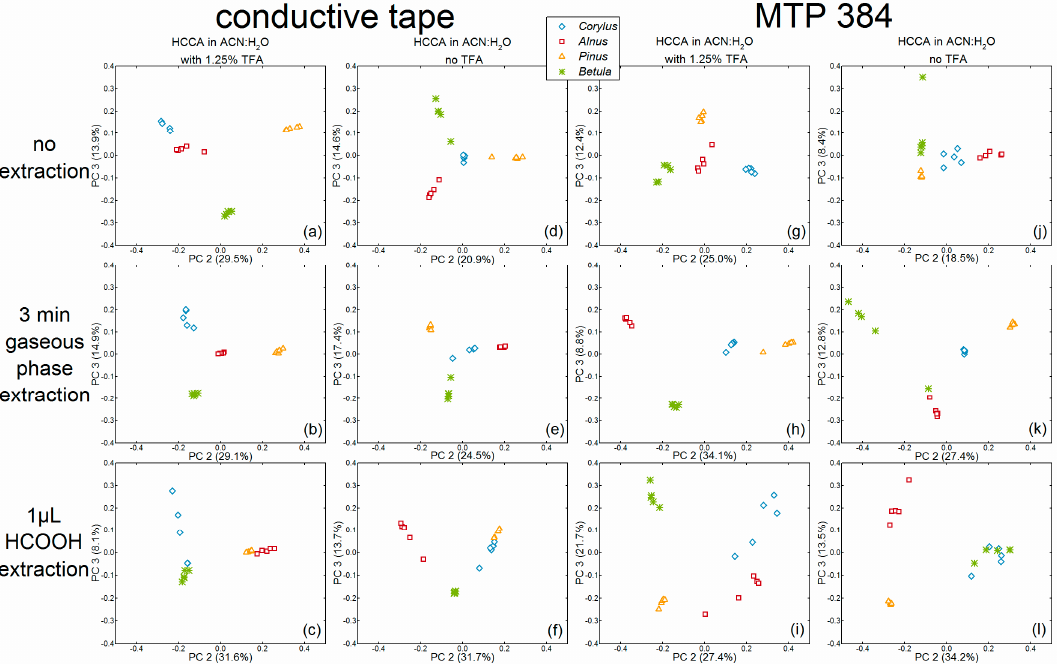
Figure A4. Scores and variances of the second and third principal component (PC) of the PCA of MALDI MS spectra from four pollen species ( Corylus avellana , Alnus cordata , Pinus sylvestris , Betula tatewakiana ) for different sample preparation techniques (rows: variation in extraction procedure (( a , d , g , j ): without additional extraction); ( b , e , h , k ): gaseous extraction); ( c , f , i , l ): droplet extraction); columns: variation in target material and matrix solution (( a – c ): conductive tape with trifluoroacetic acid in the matrix solution); ( d – f ): CT without TFA in the matrix solution); ( g – i ): steel target, matrix with TFA); and ( j – l ): steel target, matrix without TFA)). Data pre-treatment is explained in the methods Section 4.4.